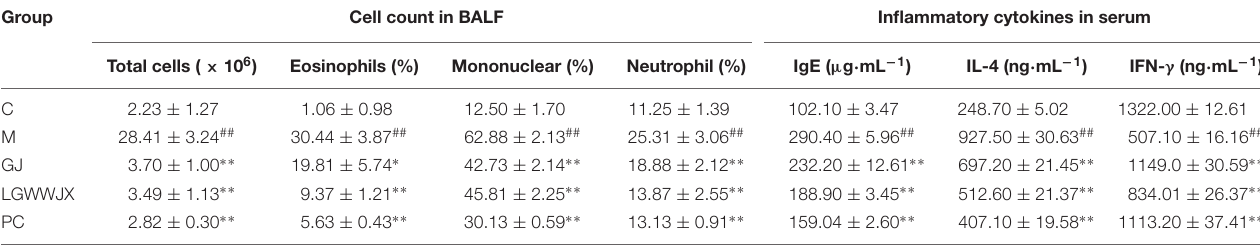
TABLE 1 | Inflammatory cells and cytokines in the four